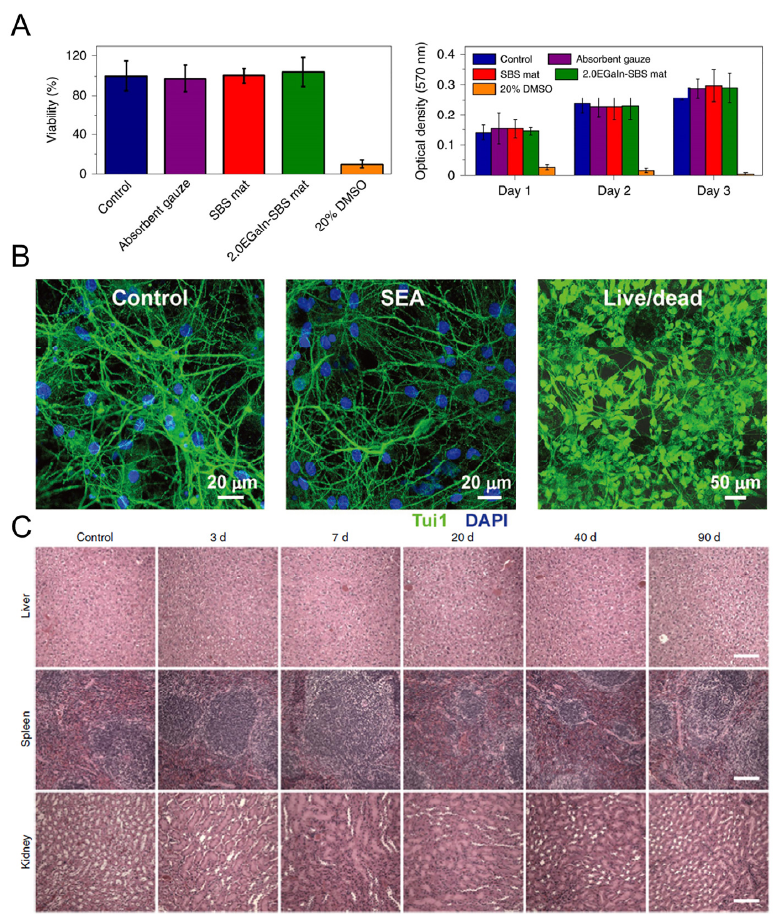
Figure 4. The biocompatibility of LMs. ( A ) The quantification of the live/dead-stained L-929 cells ( left ) and the absorption at 570 nm in MTT assay after 1–3 days of culturing [57]. Copyright: (2021) Springer Nature. ( B ) Fluorescent images of primary hippocampal neurons cultured on control tissue culture and liquid-metal-based neural electrodes at 14 days in vitro, and live/dead images of the hippocampal neurons on liquid-metal-based electrodes [59]. Copyright: (2015) WILEY-VCH. ( C )